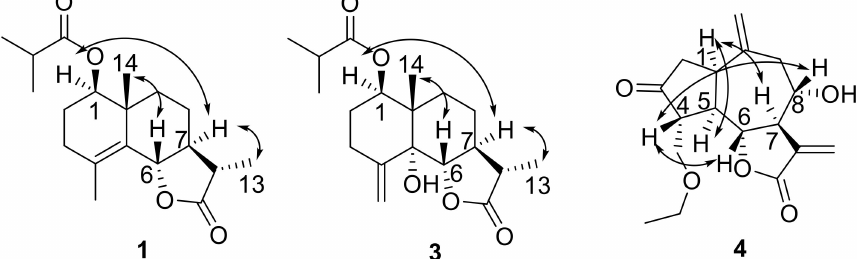
Figure 2. Key HMBC correlations of compounds 1 , 3 , and 4 .